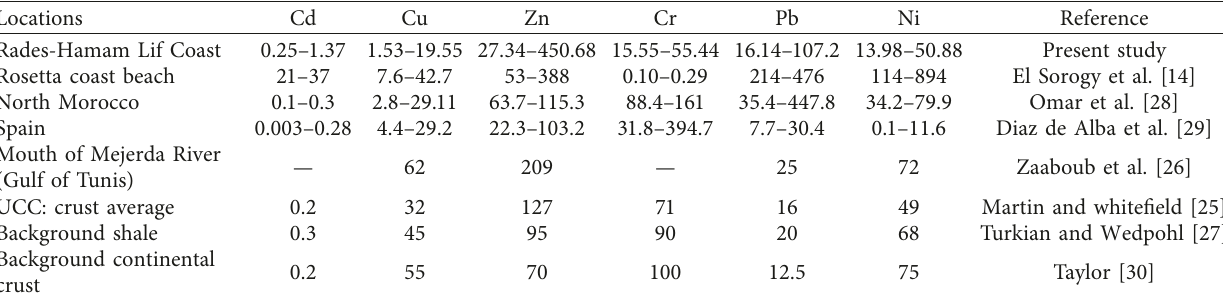
Table 5: Comparison between heavy metals in the studied sediments and other worldwide localities.